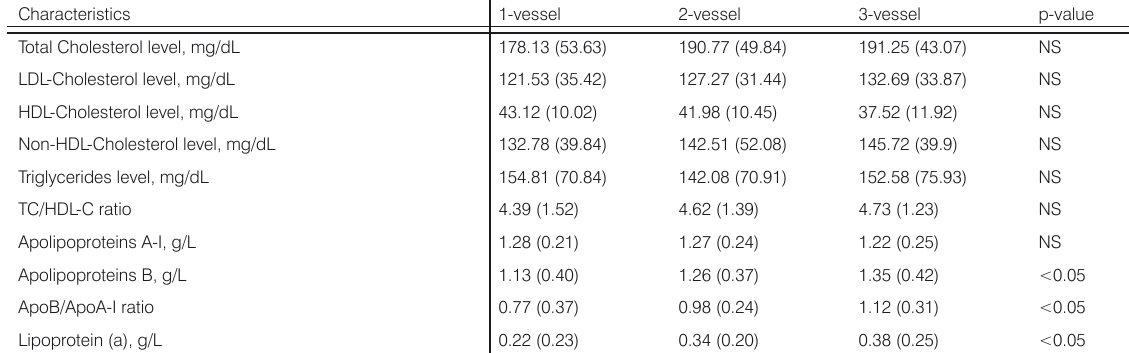
Table 2. Fasting lipids and lipoproteins in patients with 1-, 2-, and 3-vessel disease on coronary angiography.